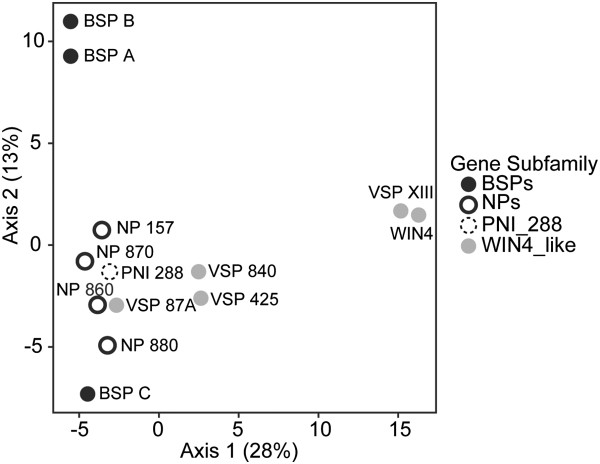
Principal component analysis (PCA) of NP-like cis-regulatory element motifs in Populus trichocarpa. PCA based upon the abundance of cis-regulatory element motifs within promoter regions of NP-like genes in Populus trichocarpa. The percentage of variation explained by each axis is given in parentheses next along each axis.